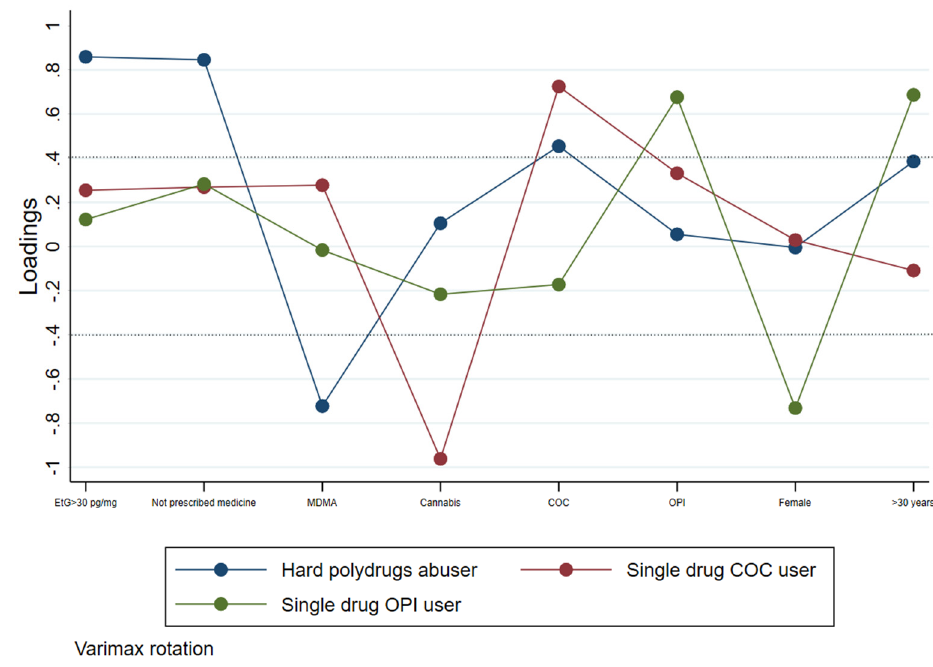
Figure 1. Profiles of drug users obtained by factors analysis. Table 1. Correlation between factors and variables (Rotated factor loadings and unique variances).